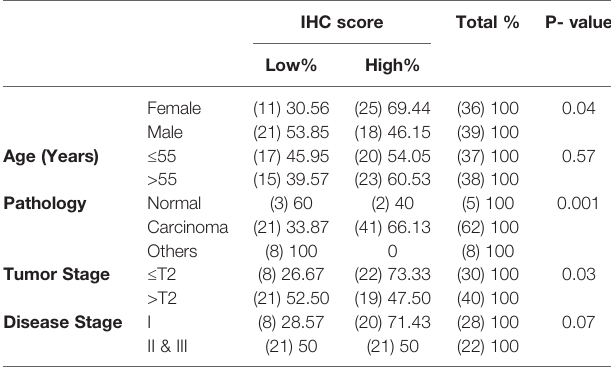
TABLE 1 | Association of clinical and pathological parameters with STIL protein expression.